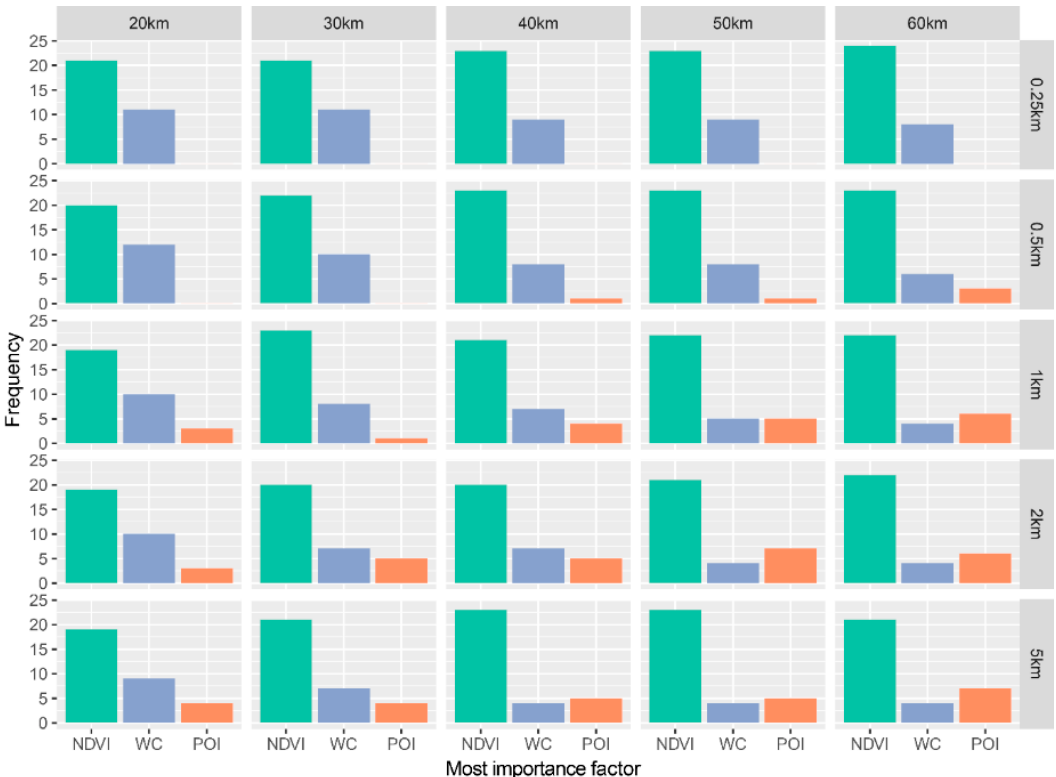
Figure 7. The frequency (number of cities) distributions of NDVI, water cover (WC), or POI density as the dominant urban-heat-island determinant that had the highest relative importance at each combination of spatial extent and grain size.